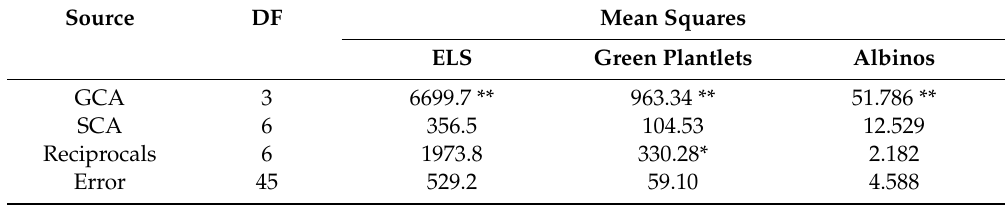
Table 5. Analyses of partitioned genotypic variance for ELS, green-, and albino plantlets. Source DF Mean Squares ELS Green Plantlets Albinos GCA 3 Reciprocals